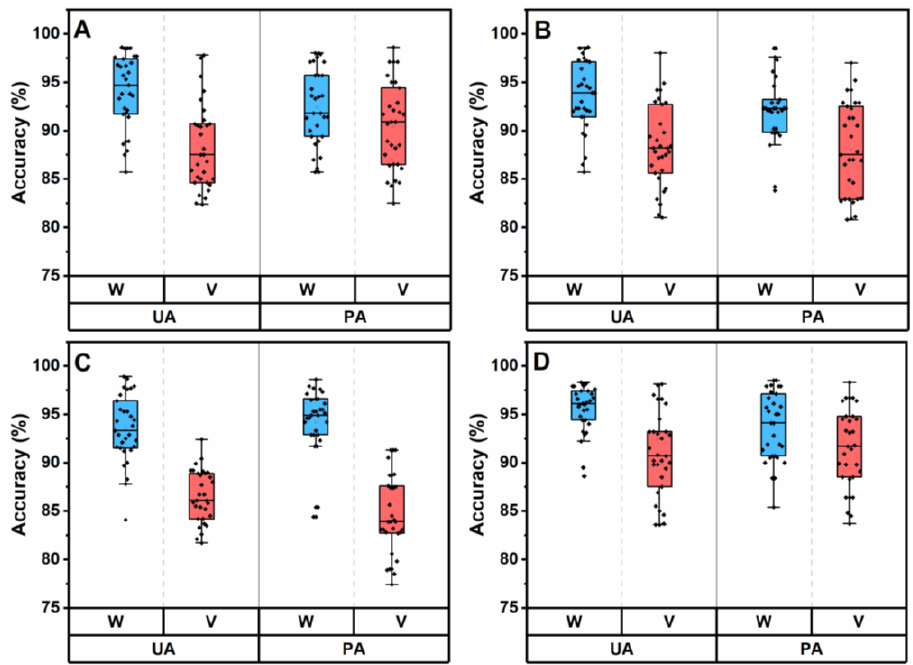
Figure 9. The UA and PA of each study site. W and V indicate the water body and vegetated wetland, respectively. The points in the graph indicate the UA and PA values from 1990 to 2020. ( A – D ) present the UA and PA of urban wetland mapping in four study sites (Site(A – D)) from 1990 to 2020, respectively.